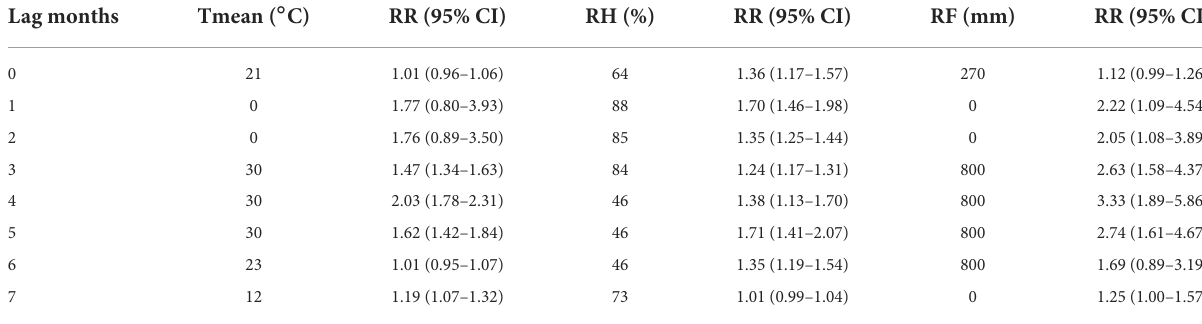
TABLE 3 Maximum RR values and meteorological parameters under different lag